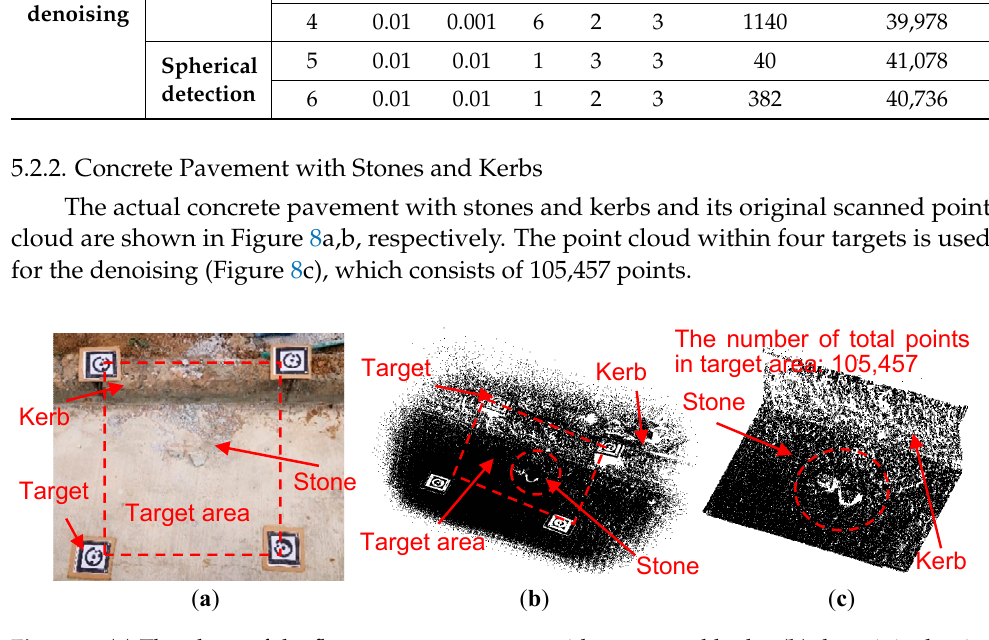
Figure 8. ( a ) The photo of the flat concrete pavement with stones and kerbs, ( b ) the original point cloud and ( c ) the original point cloud within the target